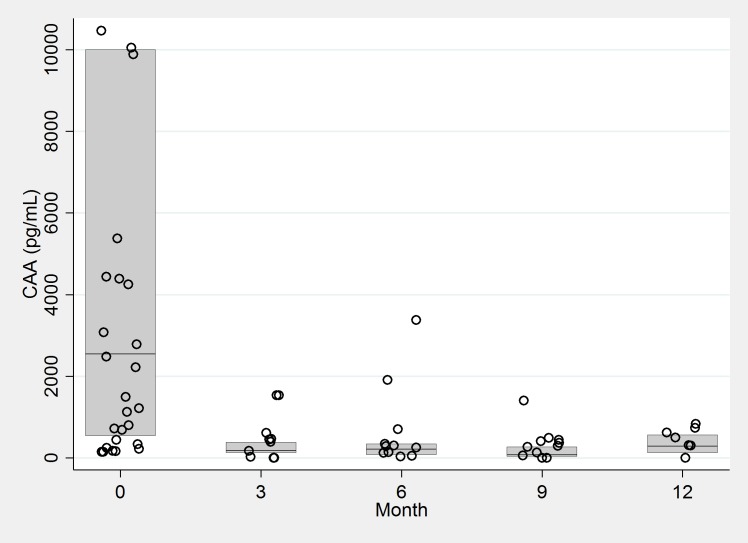
CAA values in women with Schistosoma mansoni infection at each time point.6 data points with values > 12,000, all occurring at Month 0, were included in the derivation of this box plot but are not shown.